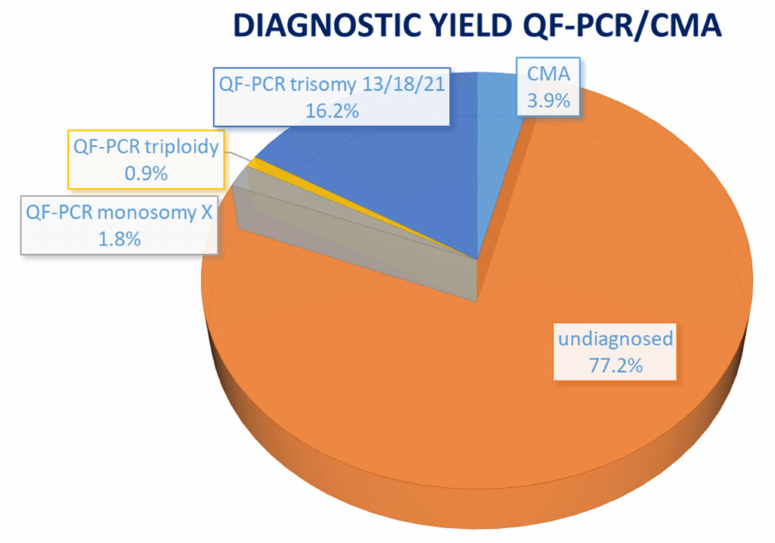
Figure 1. Diagnostic yield of QF-PCR/CMA in the prenatal context. QF-PCR: quantitative fluorescent polymerase chain reaction; CMA: chromosomal